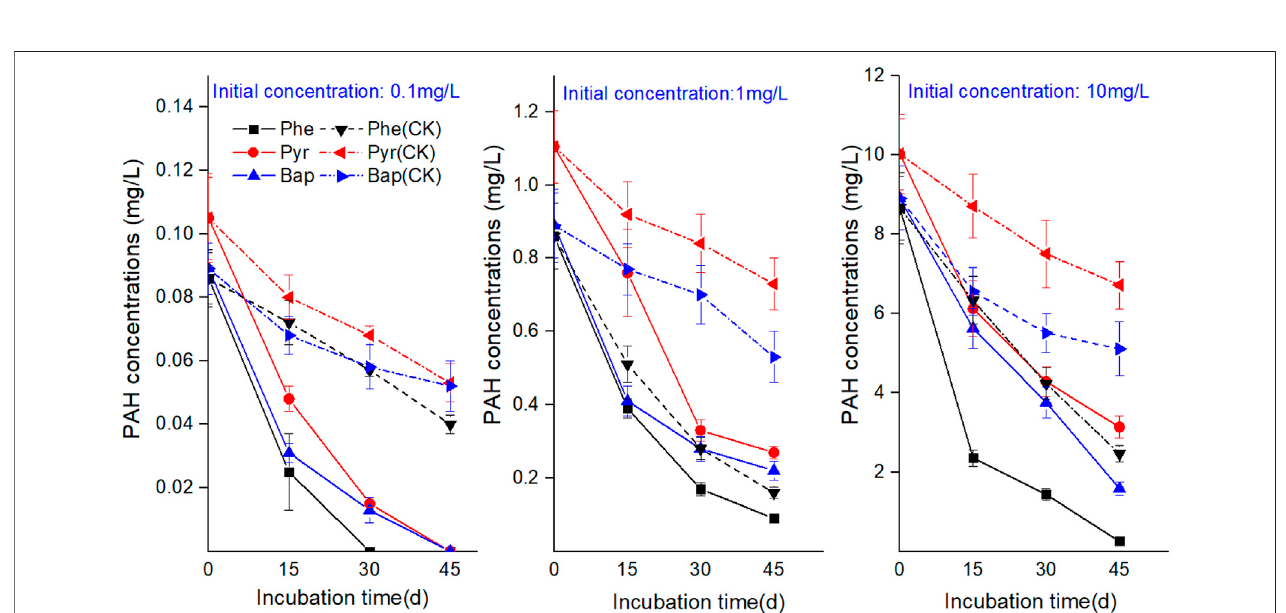
FIGURE 7 | The amount of PAHs residual in hydroponic solutions.